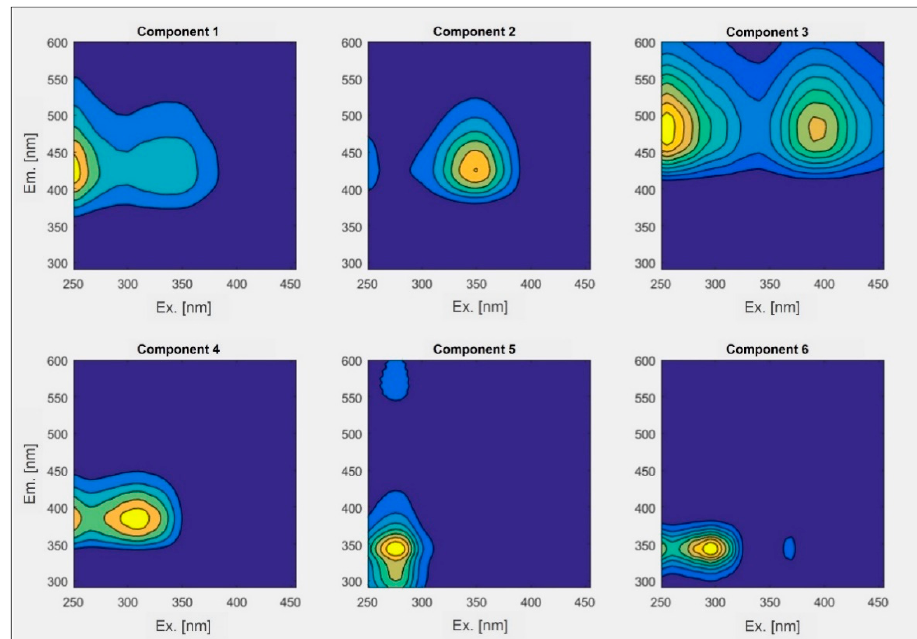
Figure 1. EEMs for the 6 components identified by PARAFAC analysis. The proportional contribution of the PARAFAC model components C1 and C3 are positively correlated with the HI (r (84) = 0.66 and 0.74, respectively, with p < 0.001, see also Figure S3) so that these components can be assigned to sources with a high degree of humification. The fluorescence peak of aquatic humic-like material, observed in both ma- rine and terrestrial FDOM, has been previously described to be at Ex/Em = 260/380–460 nm and 350/420–480 nm [38] which compares well with the excitation–emission maxima of C1 (Figure 1). However, fluorescence spectra maxima of soil samples have been ob- served at longer wavelengths than those of the aquatic samples [39]. This red shift is at- tributed to the presence of high-molecular weight fractions, electron-withdrawing sub- stituents, and a higher degree of conjugation in the organic material [39]. The EEM of pound. Free tyrosine (tyr) has an Ex/Em maximum at 275/310 nm but tryptophan (trp) PARAFAC component C3 (Em/Ex 255/484 nm & 390/484 nm) has characteristics very sim-